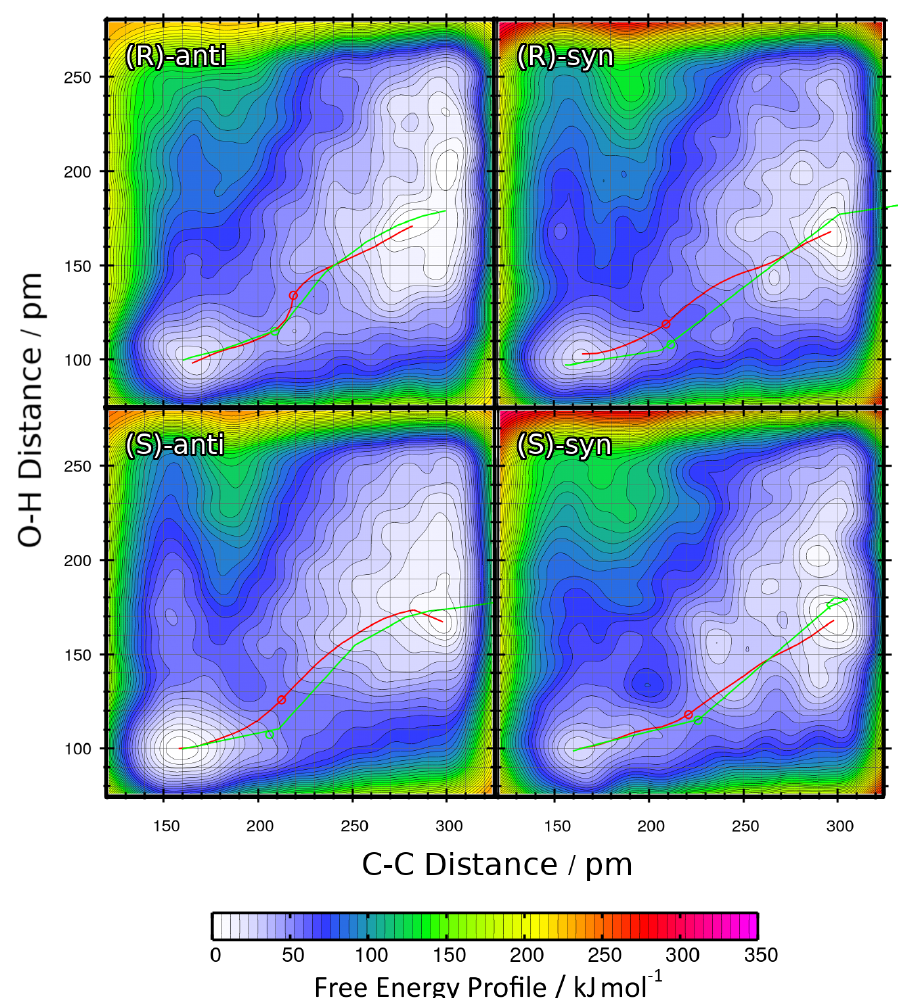
Figure 6. Free energy profiles of the aldol reactions (R=Et) in vacuum computed from HyAIMD metadynamics; definition of collective variables see Figure 2b. Red curves depict the minimum energy paths from educts (upper-right energy basin) to products (lower-left energy basin). Green curves show the results of static NEB calculations for comparison. Green circles denote the statically determined transition